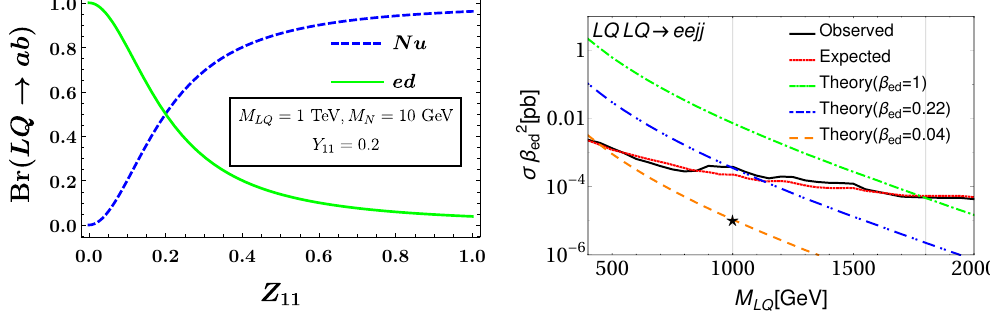
Figure 1 . Left panel: branching ratio of LQ vs Z 11 . Right panel: comparison between theory cross-section and the observed limit on eejj cross-section from the LHC. The black line is the 13 TeV LHC limit on σβ 2 [20]. The green, blue, orange lines represent the variation of theory ed cross-section σ ( pp → LQLQ) × β 2 w.r.t. LQ mass. The star denotes our chosen benchmark ed